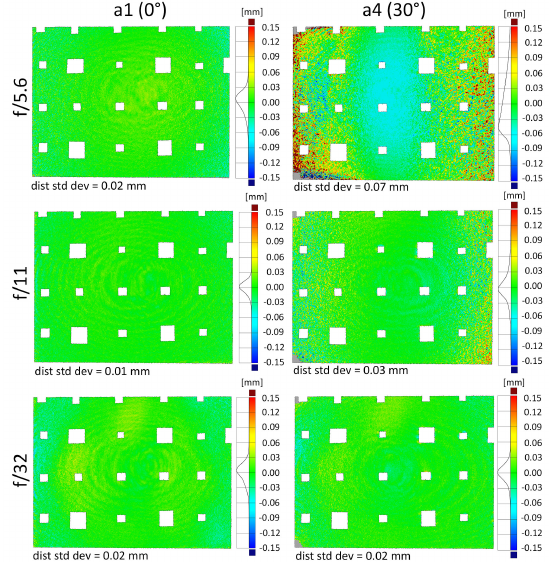
Figure 4. Surface discrepancy maps comparing 3D reconstructions with averaged reference mesh for a1 (0º) and a4 (30º) and three apertures (f/5.6, f/11, f/32).